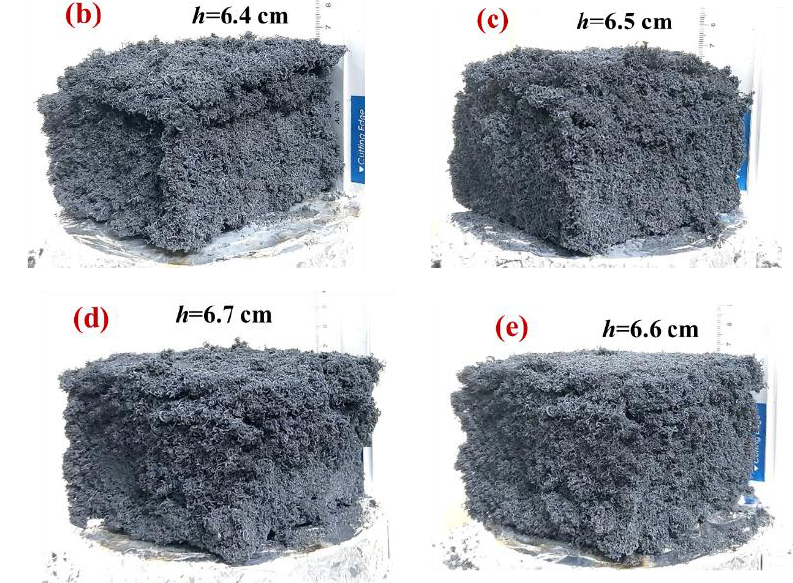
Figure 3. The digital photographs of the combusted samples: ( a ) the neat EPS, ( b ) the EPS/HFR0, ( c ) the EPS/HFR9, ( d ) the EPS/HFR12, and ( e ) the EPS/HFR15.